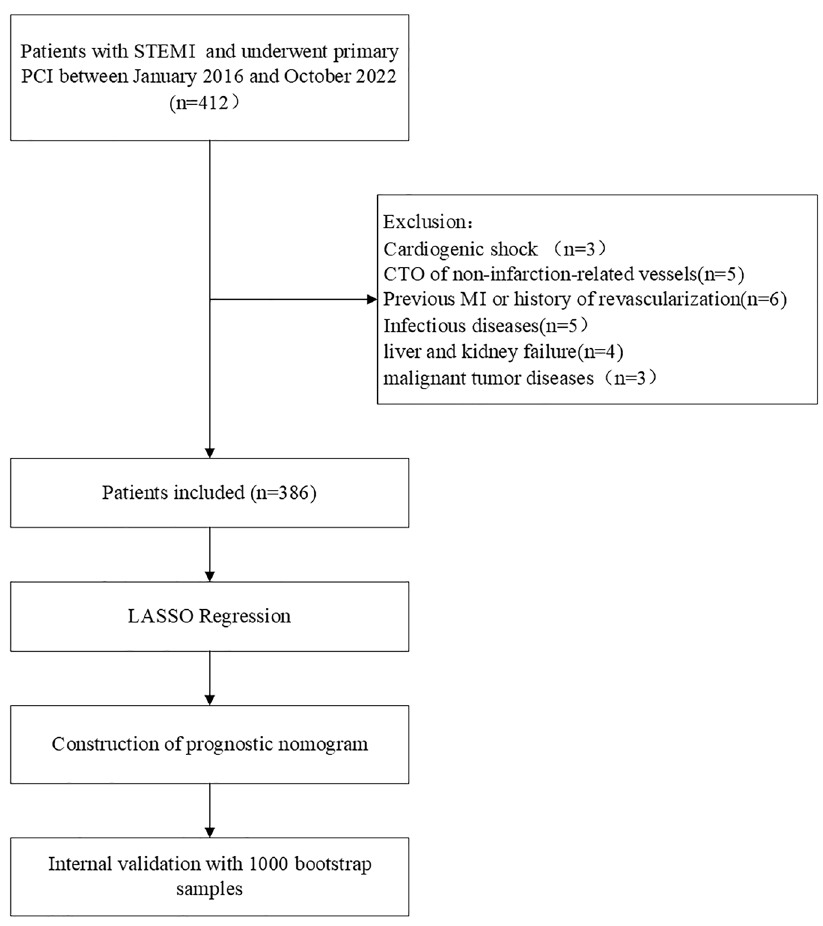
Figure 1. Study flowchart. STEMI, ST-segment elevation myocardial infarction; CTO, chronic total occlusion; MI, myocardial infarction; PCI, percutaneous coronary intervention; LASSO, least absolute shrinkage and selection